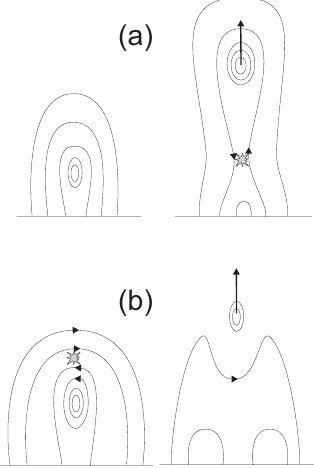
Fig. 3. Schematic drawing of the eruption where reconnection (gray explosion-symbol) takes place: (a) below the flux-rope; (b) above the